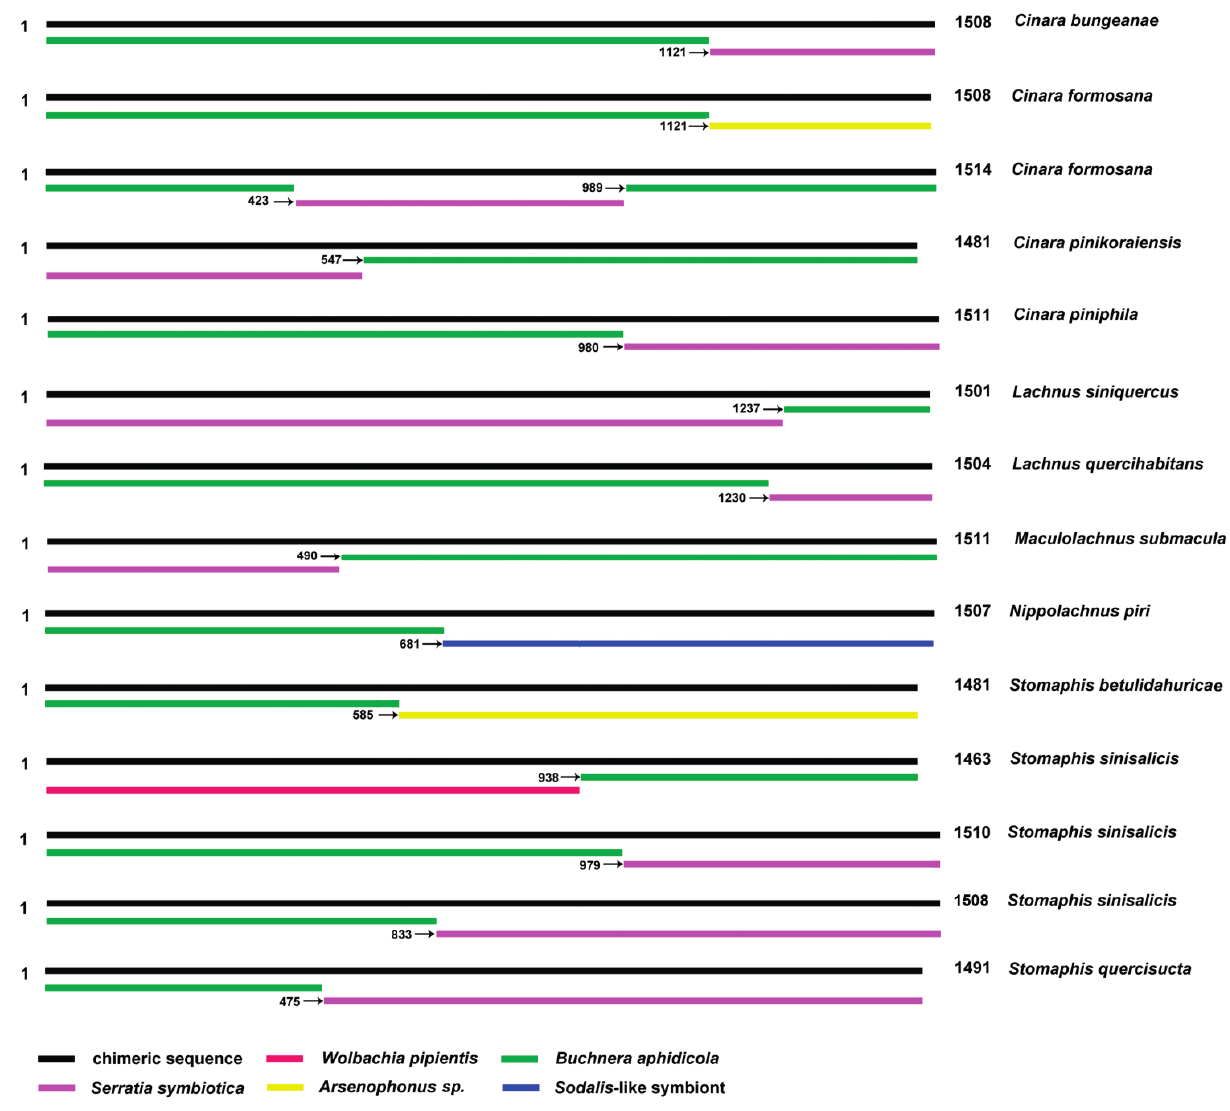
Figure 1. The types of chimeric sequences. Number at right end of bar giving length of sequence; number associated with arrow gives the sequence position where the sequence portion to the right of it